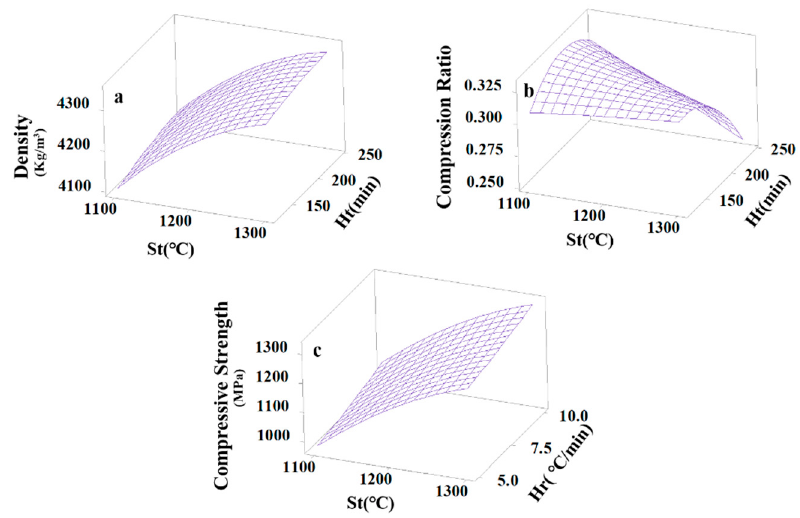
Figure 11. 3D surface diagram of ( a ) density and ( b ) compression ratio vs. sintering temperature and holding time; ( c ) compressive strength vs. sintering temperature and heating rate.